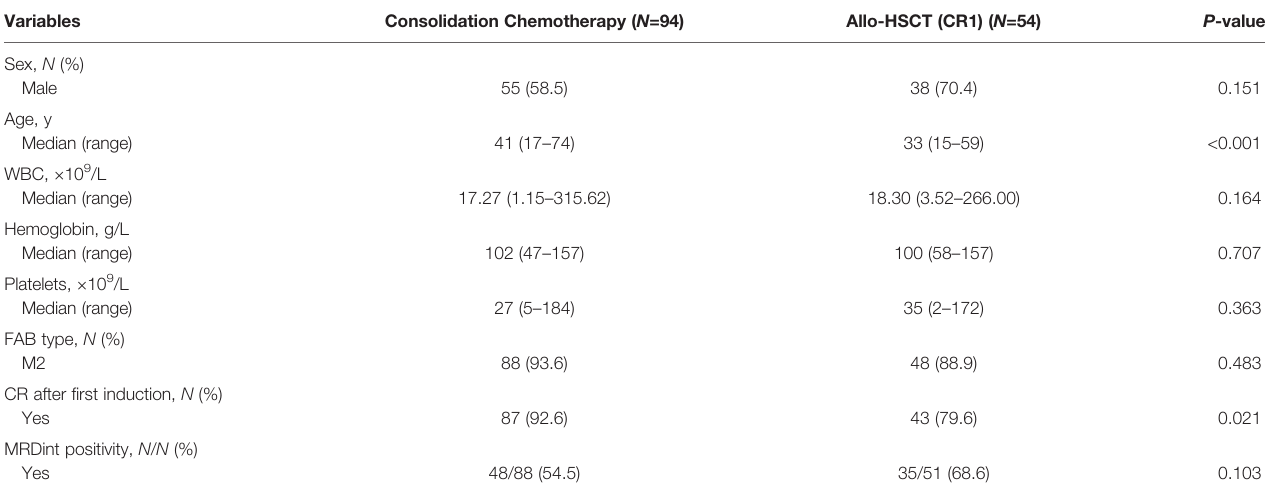
TABLE 1 | Patient characteristics categorized by post-remission